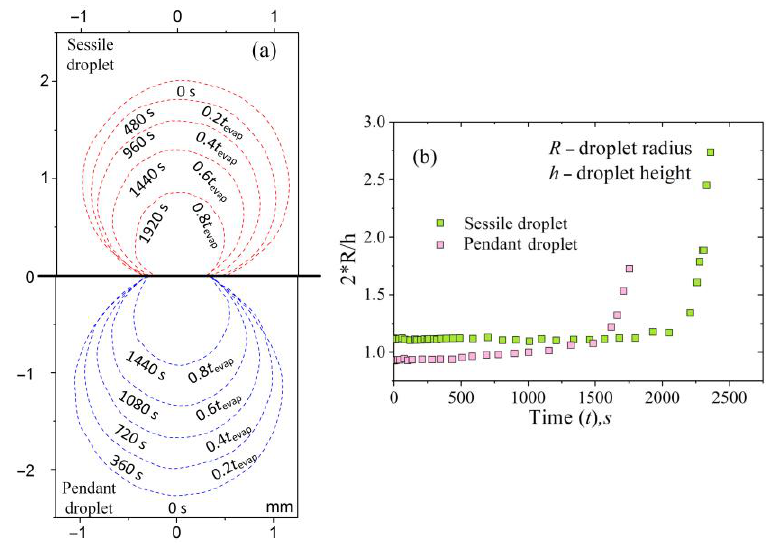
Figure 4. ( a ) Contours of sessile and suspended droplets at different times. ( b ) The ratio of the droplet diameter to its height in the process of evaporation of suspended and sessile droplets.